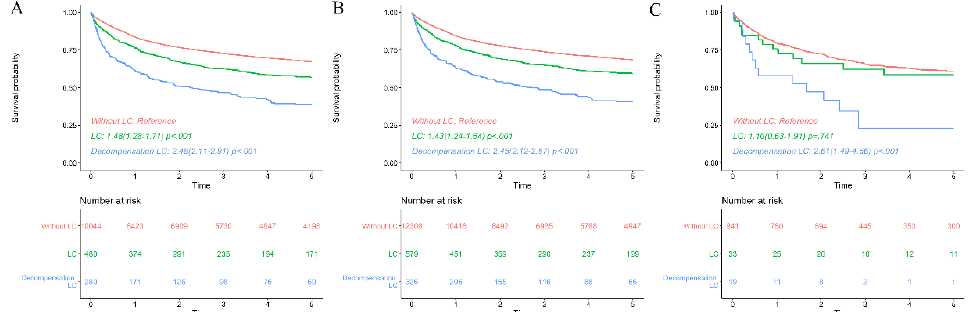
Figure 3. Survival rate of malignant lymphoma patients with chronic hepatitis B virus-diagnosed liver cirrhosis with compensation or decompensation. ( A ). The survival rate of patients with liver cirrhosis at their initial diagnosis of malignant lymphoma was significantly lower than that of patients without cirrhosis, and it was even lower in patients with decompensated liver cirrhosis. ( B ) (Mature B cell lymphoma), ( C ) (Mature T cell and NK-cell lymphoma). Subgroup analyses for each subtype showed a similar survival pattern.